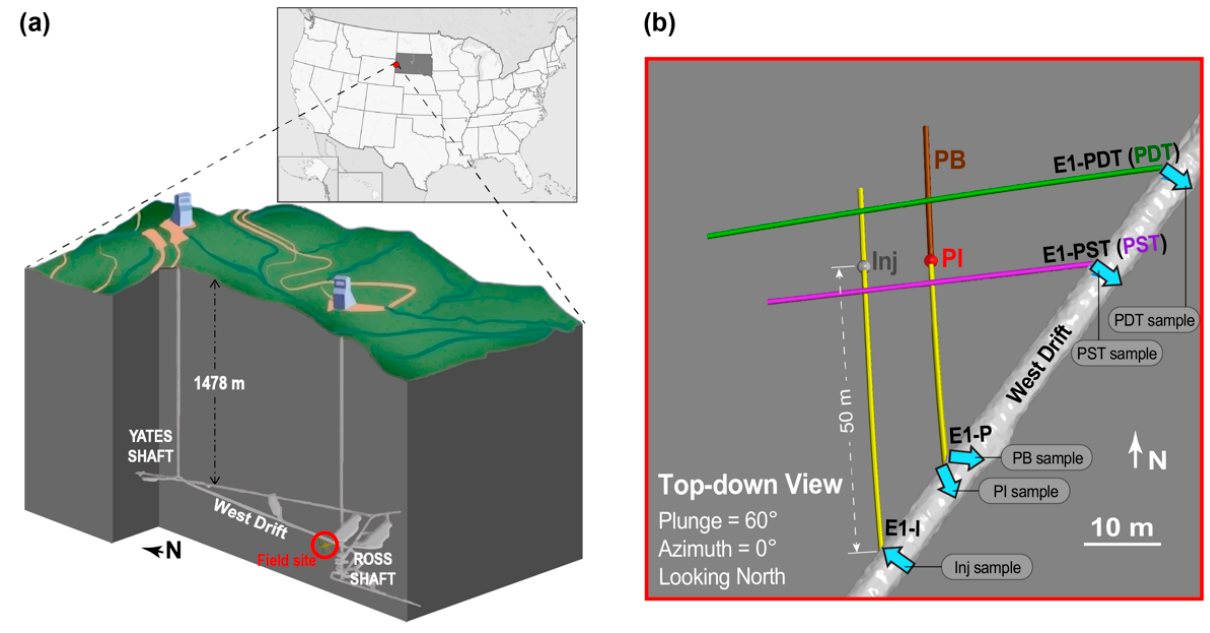
Figure 1. Deep-subsurface field site description. ( a ) Location of the EGS Collab testbed 1478-m below surface at the SURF in Lead, South Dakota, USA. ( b ) Configuration of the 4 boreholes relevant to this study, including 1 injector (borehole E1-I) and 3 producers (boreholes E1-P, E1-PST, and E1-PDT). The specific borehole intervals relevant to fluid flow include Inj (packer interval of E1-I), PI (packer interval of E1-P), PB (below the packer interval of E1-P), PDT (entire span of E1-PDT), and PST (entire span of E1-PST). All boreholes were drilled sub-horizontally into the drift wall with nonintersecting trajectories. Figure modified from